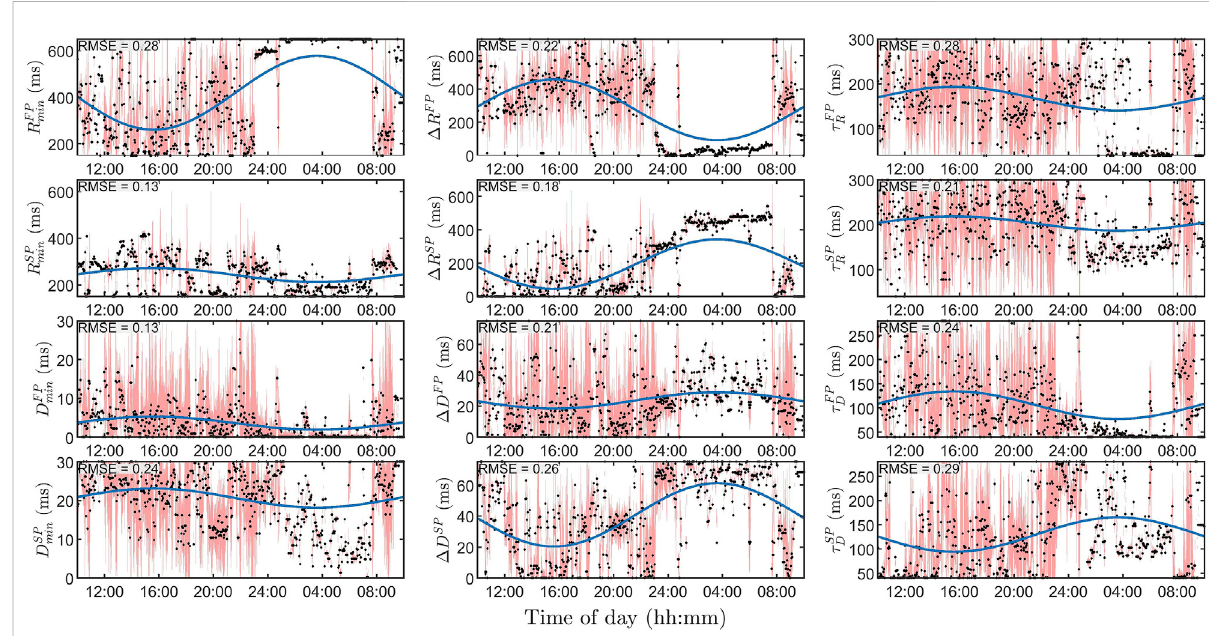
FIGURE 5 Estimated model parameters ^ θ ( i ) (black dots), with corresponding uncertainty estimates PU (red areas), along with the fi tted cosine (blue lines) usedfor thecircadian variation, forone patientduring baseline.Ineachpanel, theRMSE isreported asameasure ofgoodness of fi tbetween ^ θ ( i ) and the fi tted cosine. Left column shows the parameters relating to the minimum conduction delay or refractory period, the middle column the parameters relating to the maximum prolongation, and the right column to the time constants. For further explanation of the model parameters, see Table